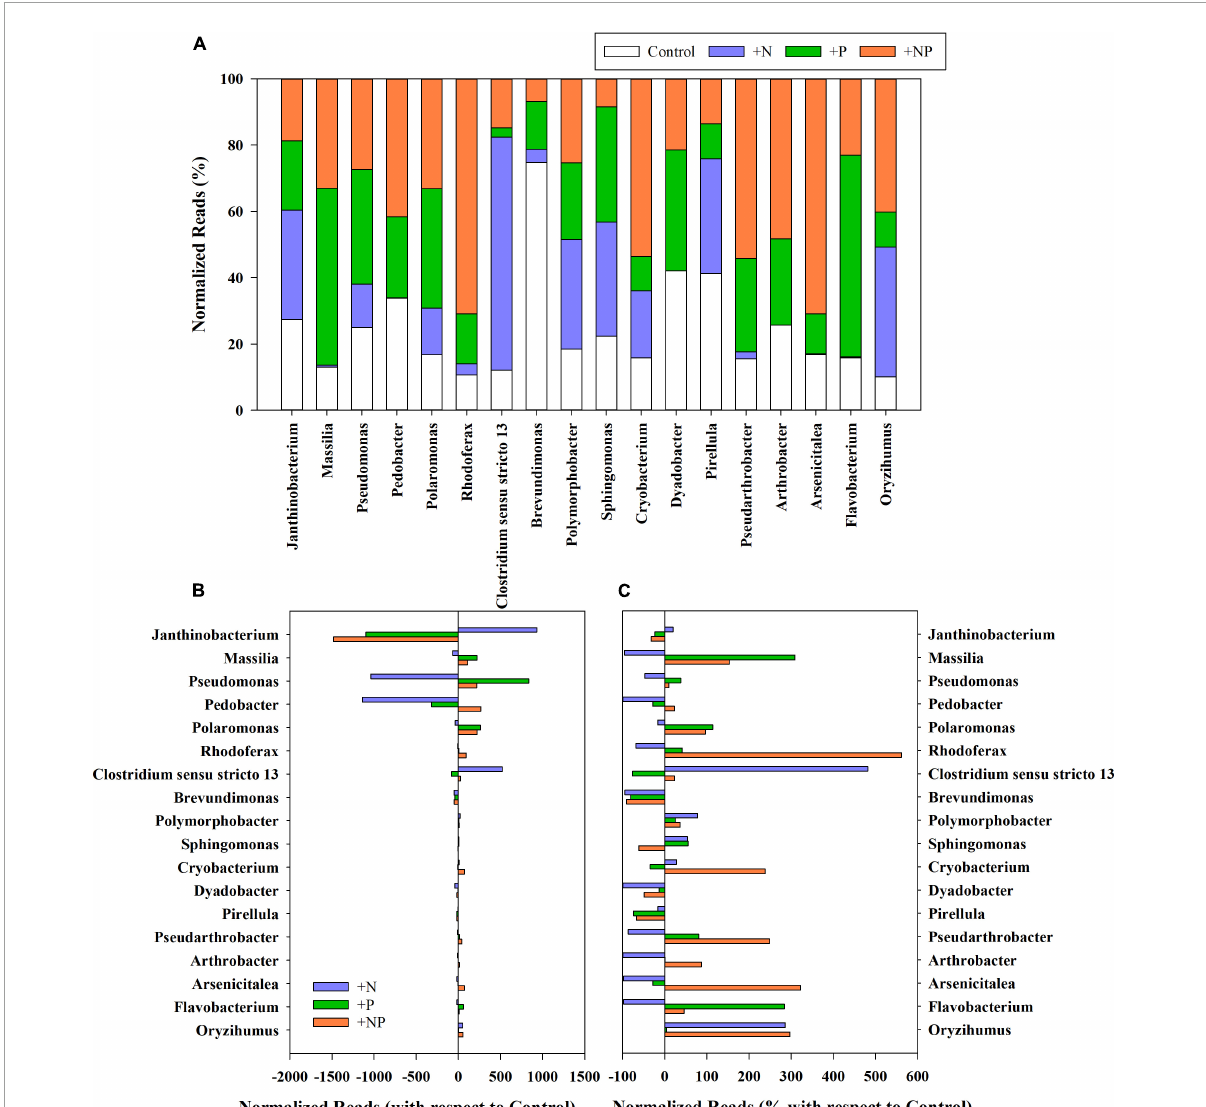
FIGURE3 (A) Relative abundance (%) of rarefied reads of the main genera present in the different treatments (C, control; P, phosphorus; N, nitrogen; and NP, nitrogen and phosphorus). (B) Variation of the normalised reads in the different nutrient amendment treatments with respect to the control for the main genera present in the studied microbial mat. (C) Percentage of variation of the normalised reads in the different nutrient amendment treatments with respect to the control for the main genera present in the studied microbial mat. Only genera with more than 0.1% of the total reads in all treatments have been